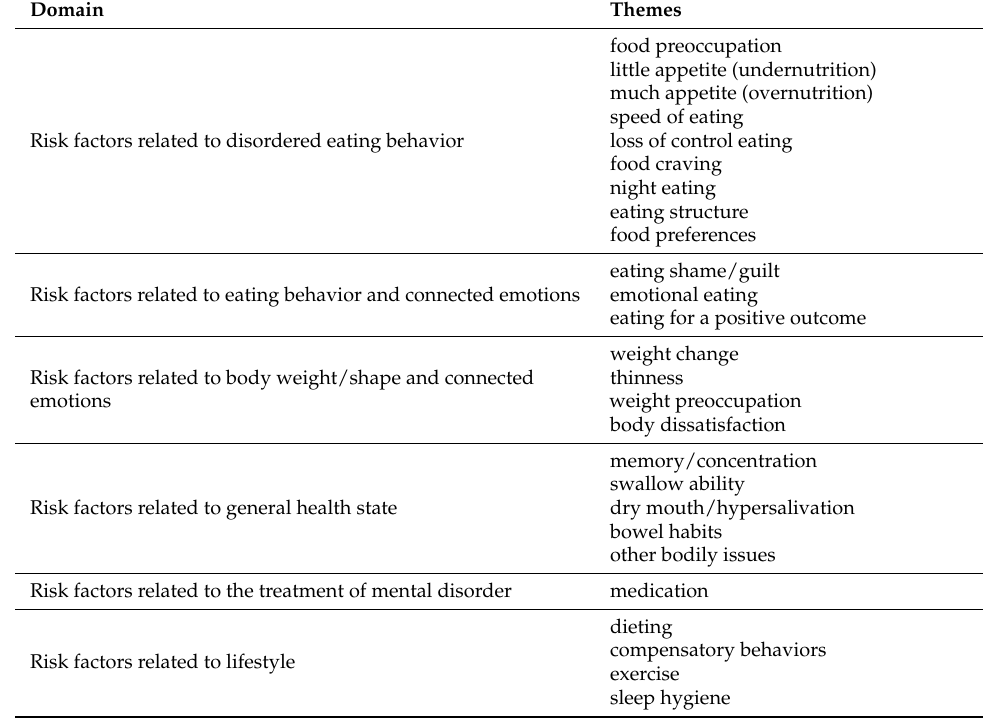
Table 1. Domains and themes development.